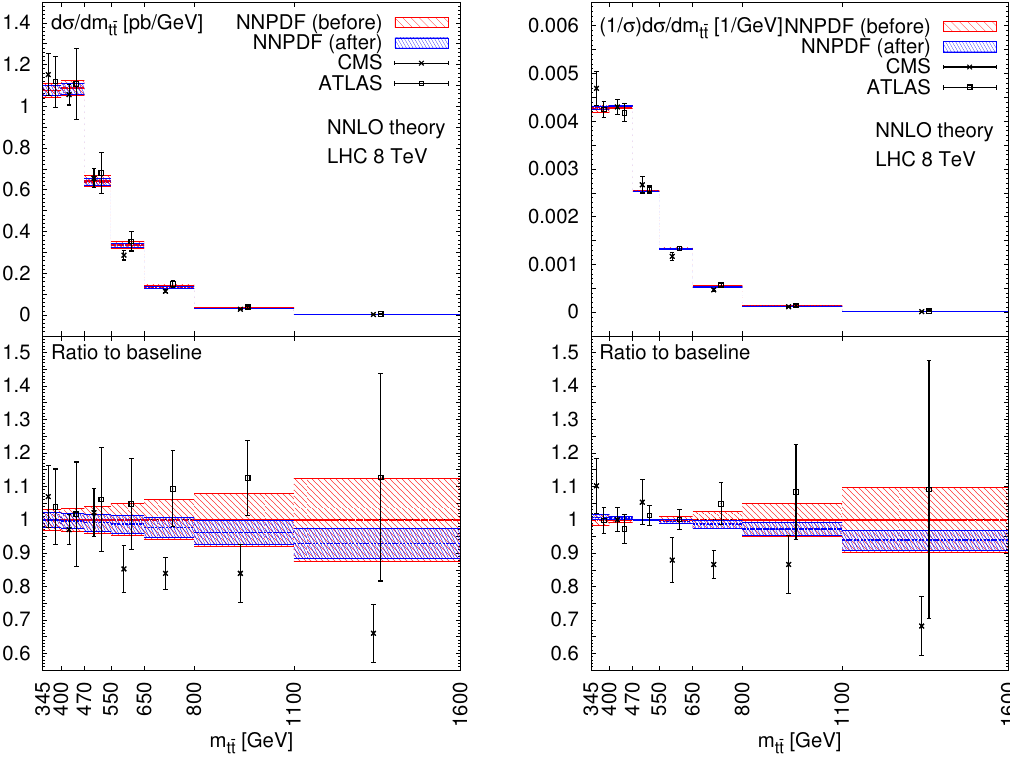
Figure 19 . The NNLO theoretical predictions for the absolute (left) and normalized (right) m t (cid:22) t distributions at the LHC 8 TeV, obtained from the global PDF (cid:12)t before and after the optimal combination of top data has been included. The theory predictions include only the 1{ (cid:27) PDF uncertainty band, while scale uncertainties are not shown. The lower panels show the results as a ratio to the baseline